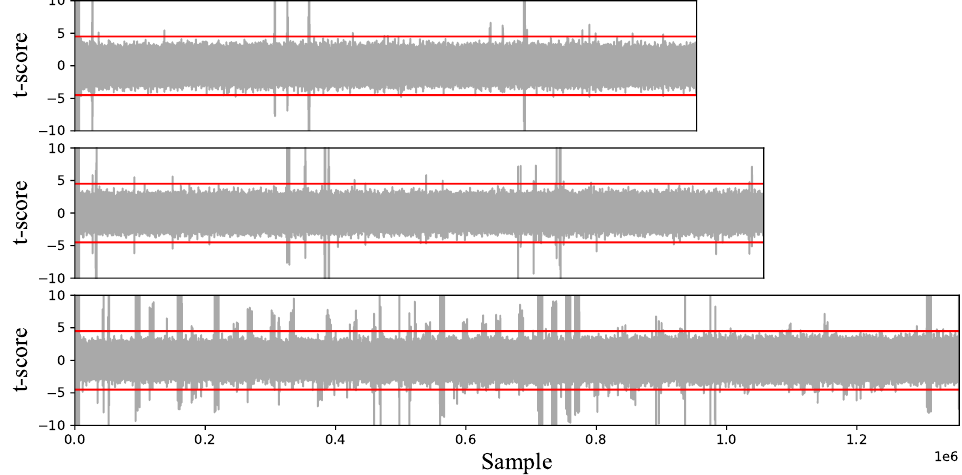
Figure 6: TVLA (t-test) results for BM k =1 (top), BM k =2 (middle) and BM k =4 (bottom) with a sampling rate of 100 MHz. The red lines mark the ± 4 . 5